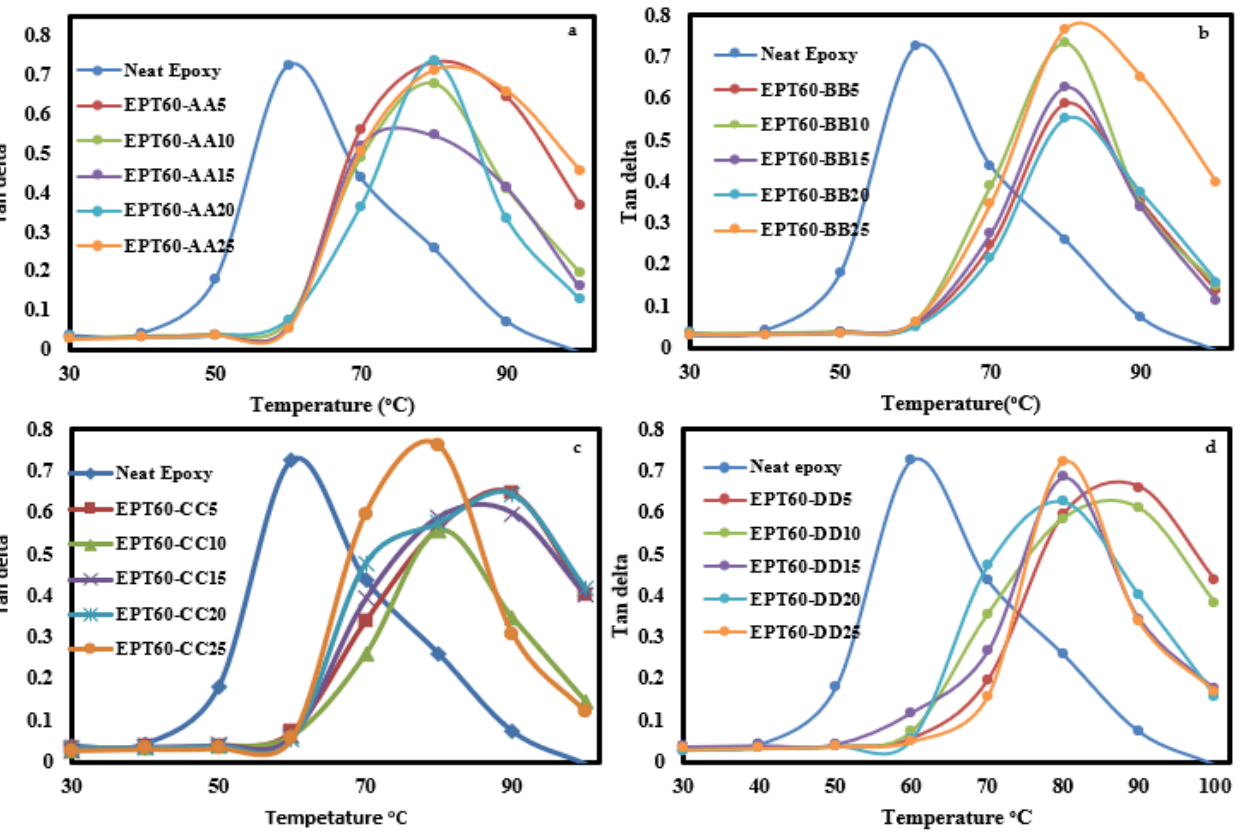
Figure 11. The damping parameter, Tan δ of SFC-homogenous HGM at ( a ) EPT60-AA, ( b ) EPT60-BB, ( c ) EPT60-CC, and ( d ) EPT60-DD. Showing all the volume fraction variations compared with the neat